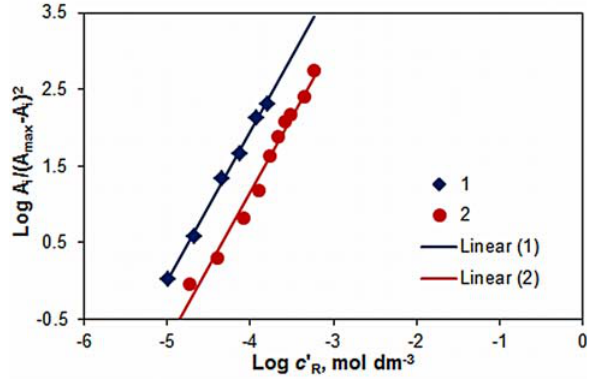
Figure 4. Determination of R-to-V(V) molar ratios by the mobile Figure 2. Absorbance of the complex (curve 1) and blank (curve 2) equilibrium method. The data are derived from the experimental = 2 × 10 –5 mol dm –3 , in chloroform vs pH of aqueous phase. c points shown in Fig. 3. Straight line equations: (1) y = 1.95 x + 9.75 V(V) c (R = TAO, r 2 = 0.9974); (2) y = 1.96 x + 8.98 (R = TTC, r 2 = 0.9824)